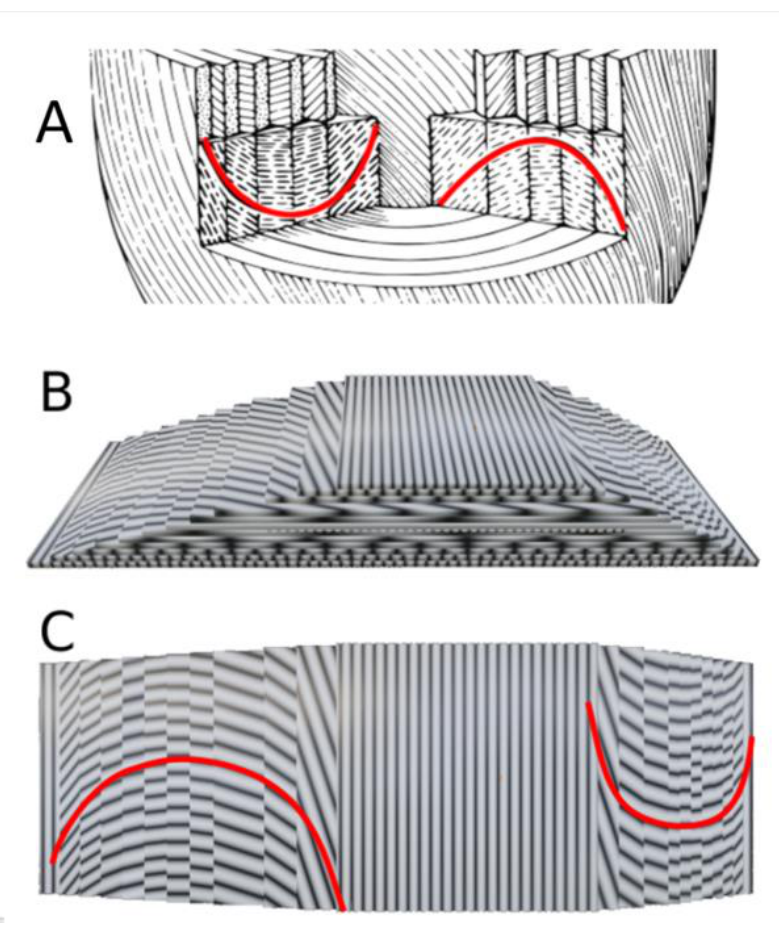
Figure 10. Comparison between a sketch modeled after Feneis and a sketch modeled after Bouligand. Arches highlighted in red in both diagrams illustrate the similarity of sectional artefacts seen in the ventricular myocardium and in the integuments of arthropods. ( A ) Feneis-like Sketch of the ventricular wall. ( B ) Bouligand-like sketch of the integuments of arthropods. The cuticle was cut obliquely on two sides to make a pyramid in order to reveal the plywood organisation and the progressive rotation of chitinous rods. ( C ) Top view of ( B ).